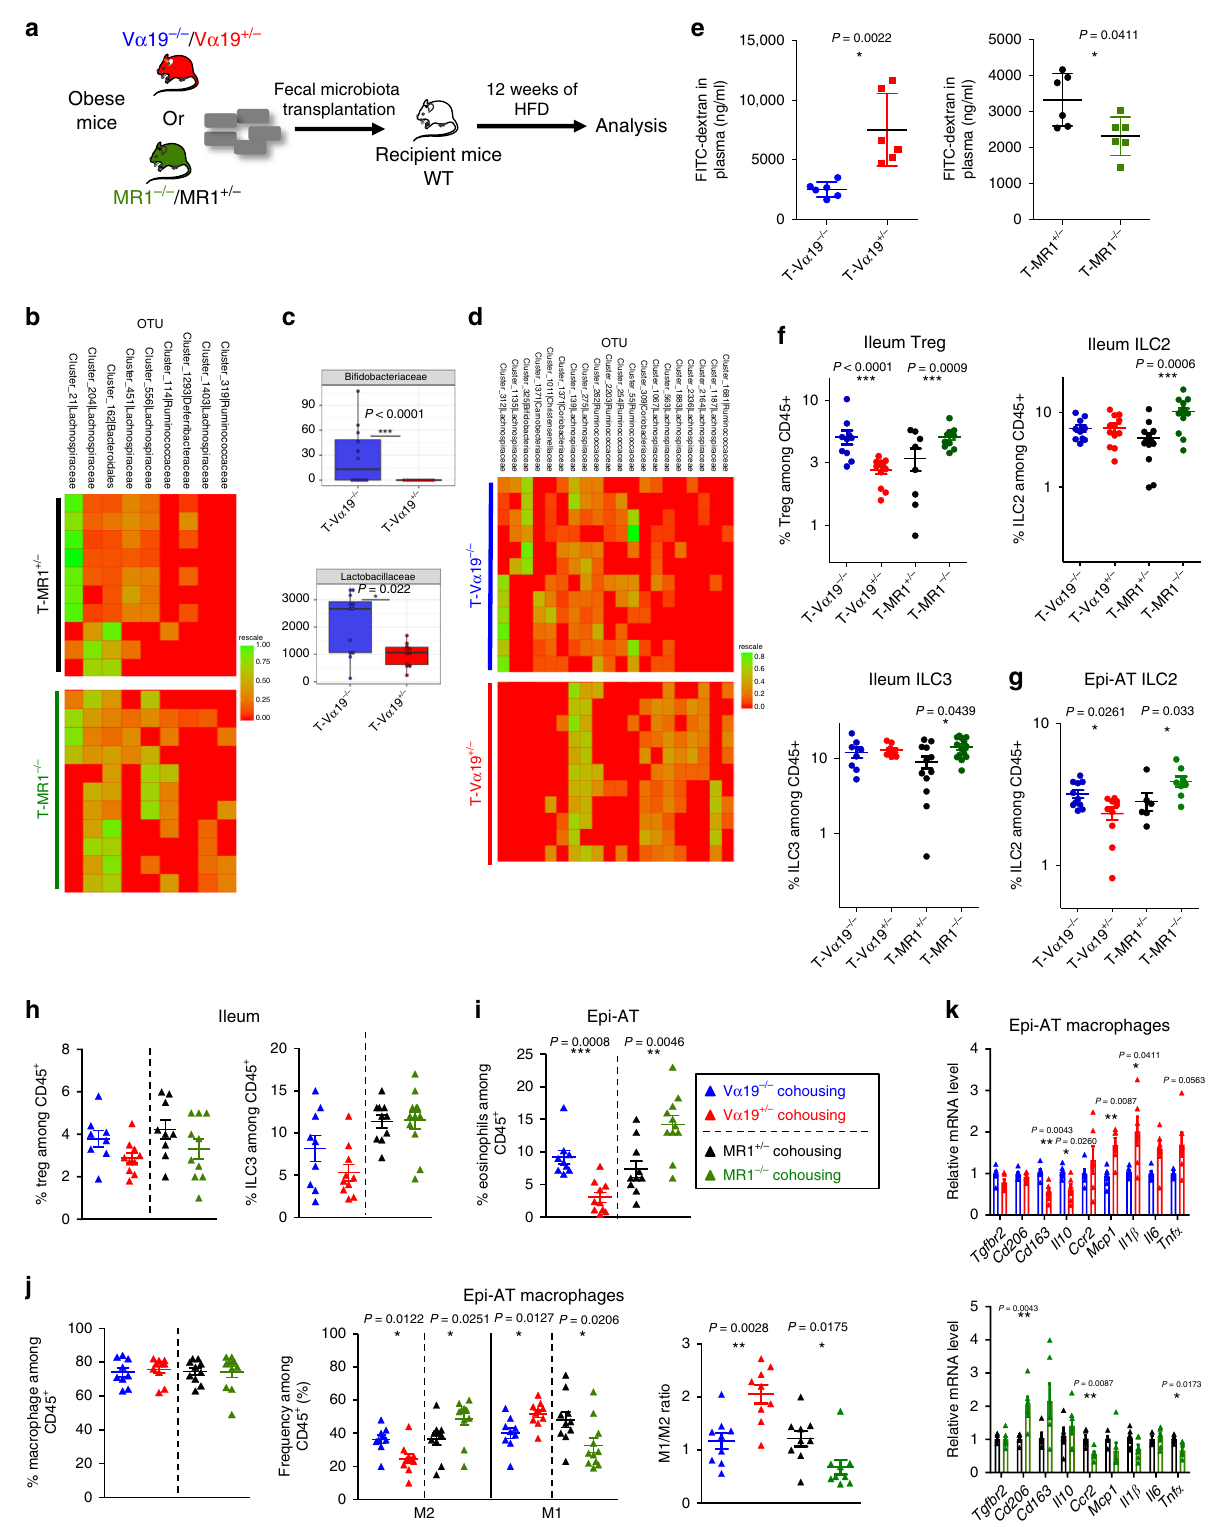
In vivo analysis of intestinal permeability . In vivo intestinal permeability was evaluated by the intestinal permeability of FITC-dextran 4 kDa. Brie fl y, 6-h water- fasted mice were gavaged with FITC-dextran 4kDa by gavage (600mg/kg body weight, 120 mg/ml; Sigma-Aldrich, St Louis, MO). After 4h, 120 μ l of blood were collected from each mouse from the retro-orbital vein. The blood was centrifuged at 4°C, 10,000 rpm, for 5min. Plasma was analyzed for FITC-dextran 4kDa concentration with a fl uorescence spectrophotometer (SPARK 10M, TECAN) at excitation and emission wavelengths of 485nm and 535 nm, respectively.